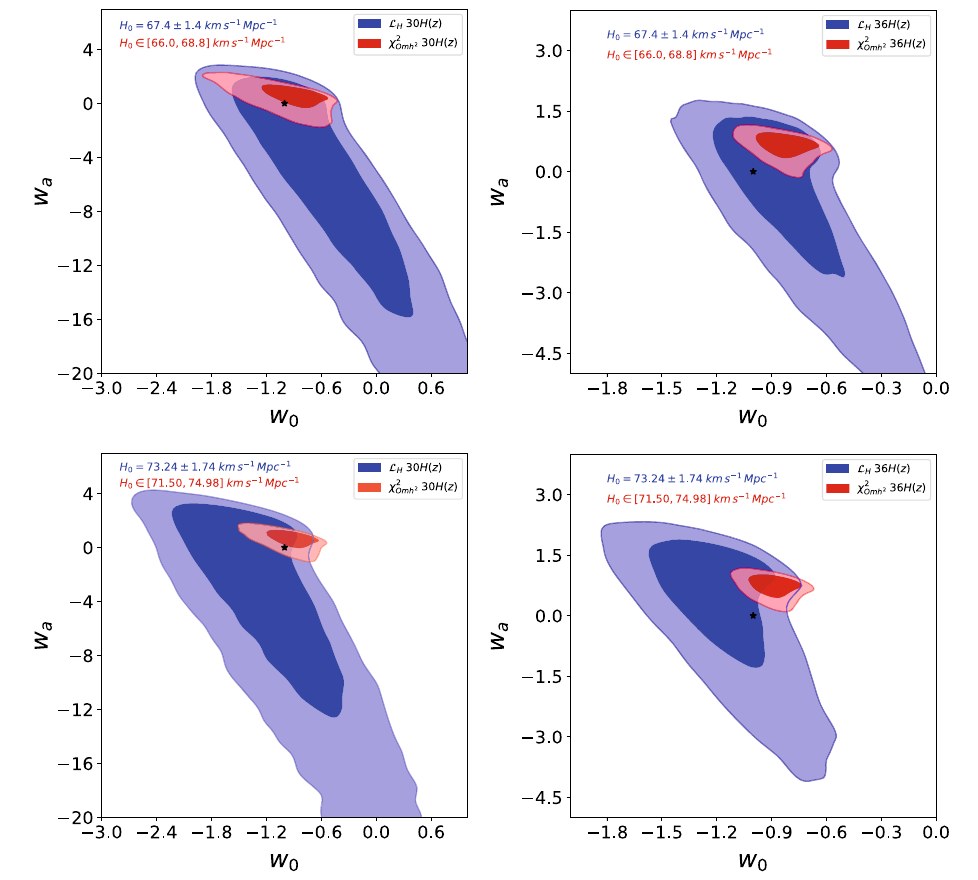
Fig. 4 ConstraintsontheCPLparametersfrom30DAH(z)datapoints and 36 total sample. Blue contour: hubble parameters constraint with H 0 Gaussianpriors;Redcontour: Omh 2 ( z i , z j ) methodconstraintwith